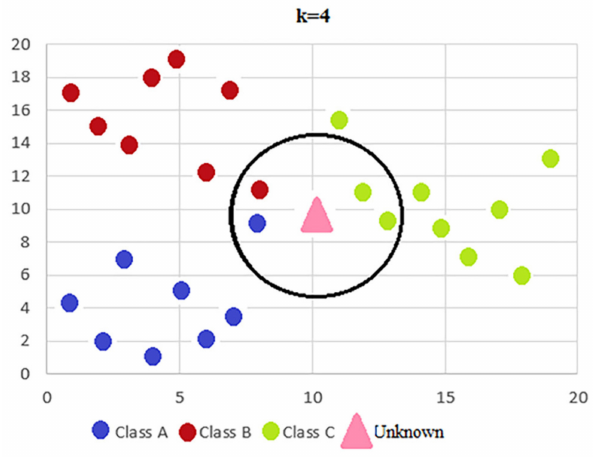
Figure 8. Graphical representation of KNN